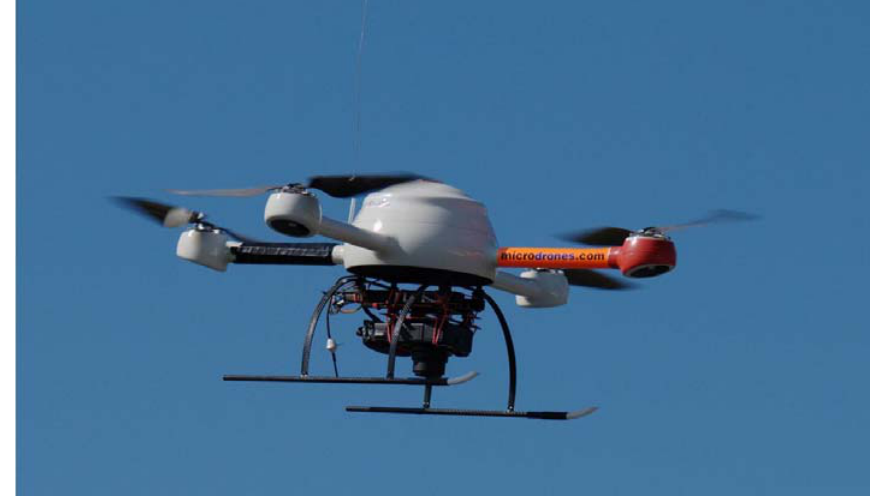
Figure 1. Microdrone md4-200 with a Ricoh GR3 compact